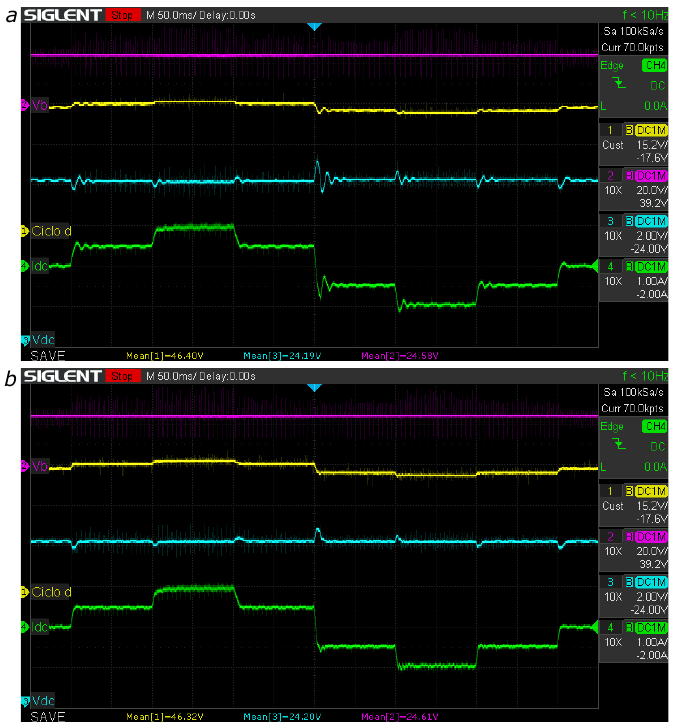
= 24 V (unitary gain mode) using ( a ) PI ref